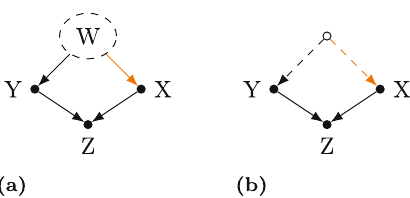
Figure 1: ( a ) Posited DAG for the pneumonia example of ref. [ 11 ] . Y represents the target condition, pneumonia. X represents the X - ray style features ( e.g., orientation and color encoding scheme ) . Z represents the x - ray itself. W represents the hospital department the patient visited. The orange edge represents the unstable style feature mechanism, while the dashed node represents an unobserved variable. ( b ) The corresponding ADMG for the DAG in ( a ) . The unobserved confounder W has been replaced by a bidirected